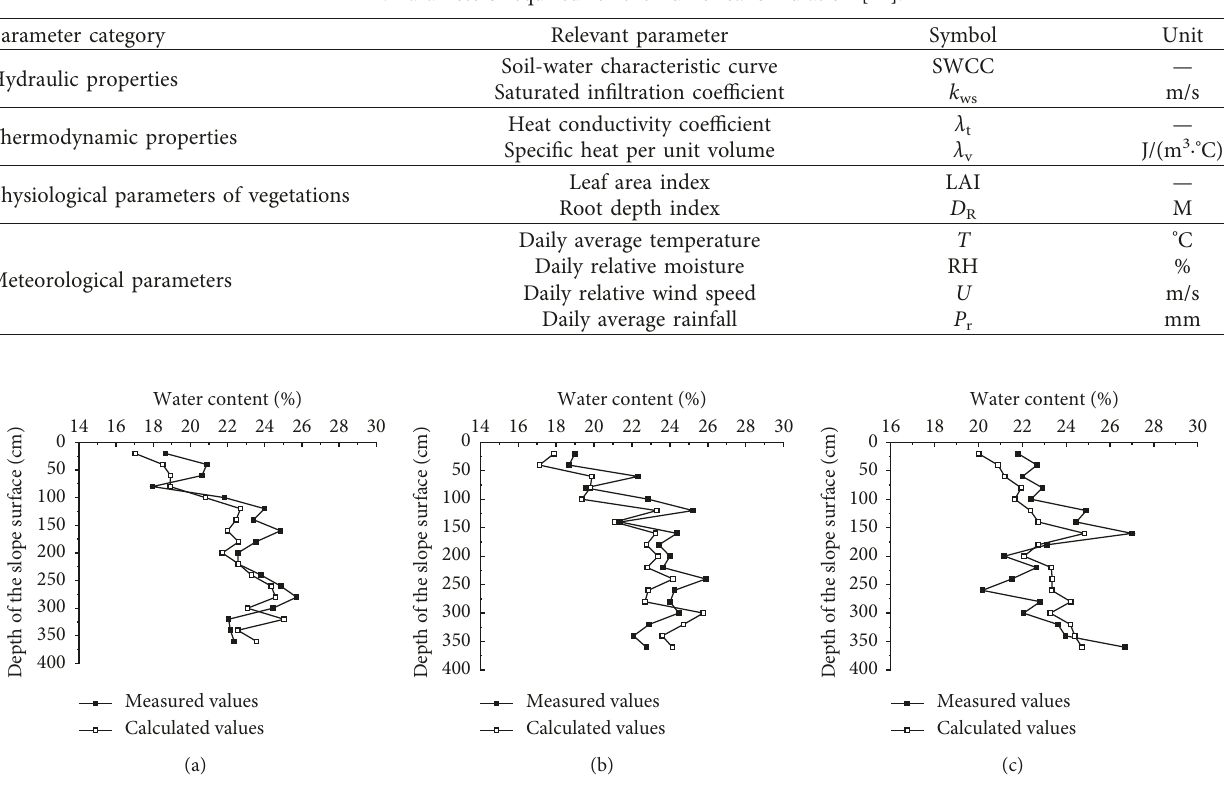
Figure 9: Calculated and measured water content values of soil at each vertical section. Comparison of vertical section: (a) V1; (b) V2; (c) V3.